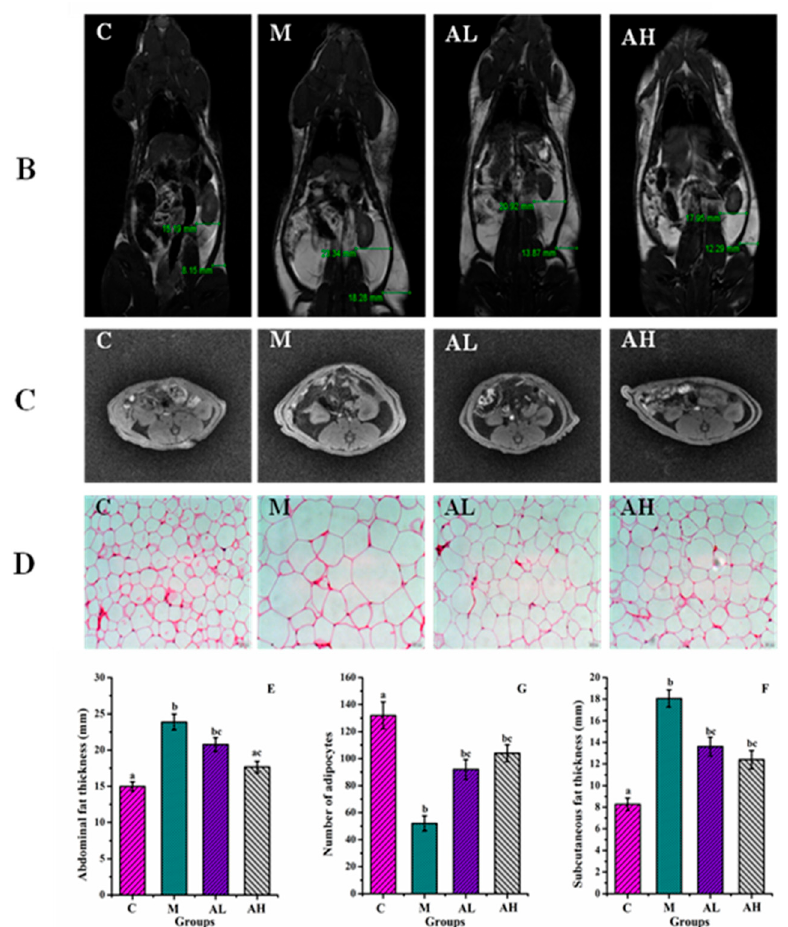
Figure 3. Body weight changes, distribution, and thickness of abdominal and subcutaneous fat in rats detected by magnetic resonance imaging (MRI), and the adipocyte number changes in rats. ( A ) Body weight changes of rats over 12 weeks ( n = 6). ( B ) Distribution of abdominal and subcutaneous fat. ( C ) Results of in-phase and out-of-phase magnetic resonance imaging. ( D ) H&E staining of adipose tissue ( n = 6). ( E ) Thickness of abdominal fats ( n = 3). ( F ) Thickness of subcutaneous fats ( n = 3). ( G ) Adipocyte number changes ( n = 6), which were calculated manually. Data in ( B , C ) were all expressed as mean ± SE. The white component in Figure 3B and the black component in Figure 3C is adipose tissue. C: Control group, M: Model group, AL: Low dose ethanol extract group (200 mg/kg), AH: High dose ethanol extract group (600 mg/kg). Data were expressed as the mean ± SE. Different letters indicate significant differences ( p <